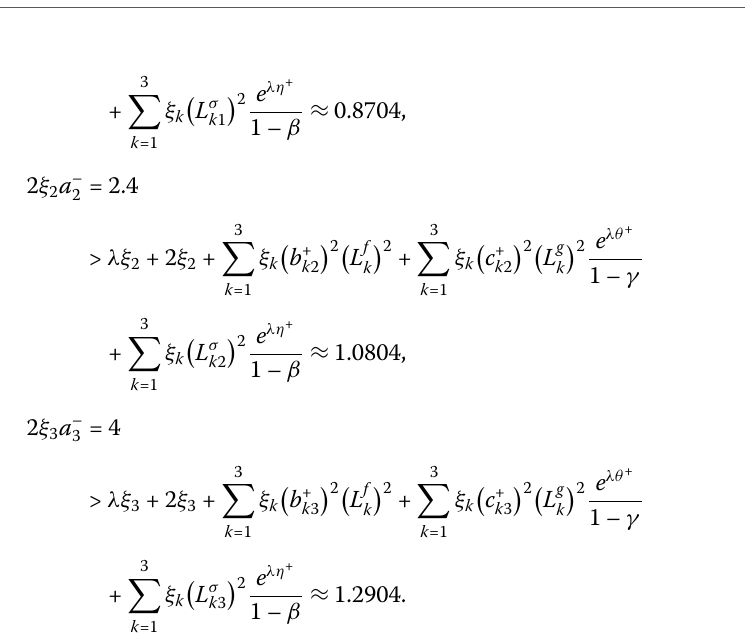
( t ) of system (4.1) with U R l